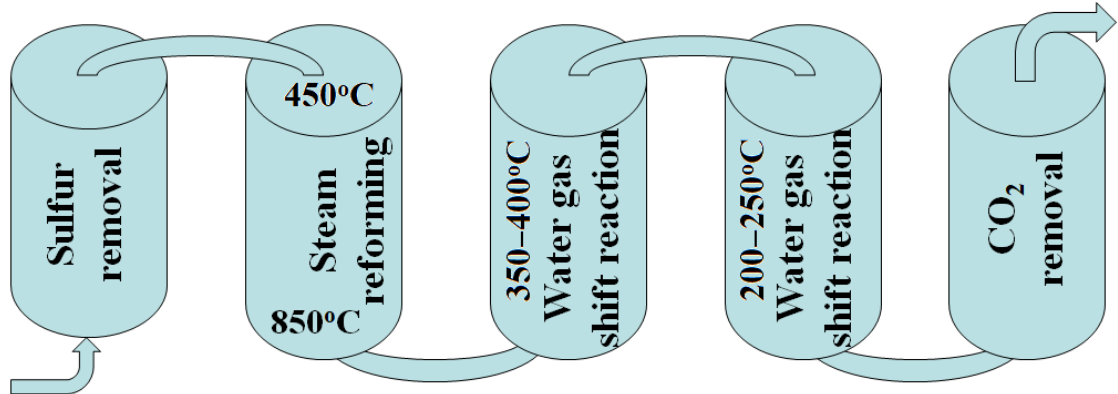
Figure 2. Scheme of steam – methane reforming for H 2 production.